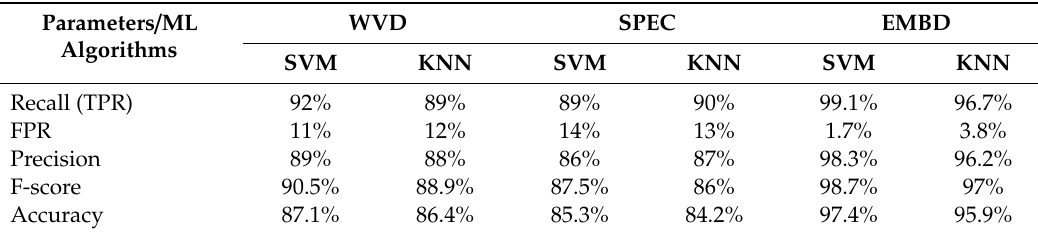
Table 4. Evaluation parameters in classifying ST-elevation.